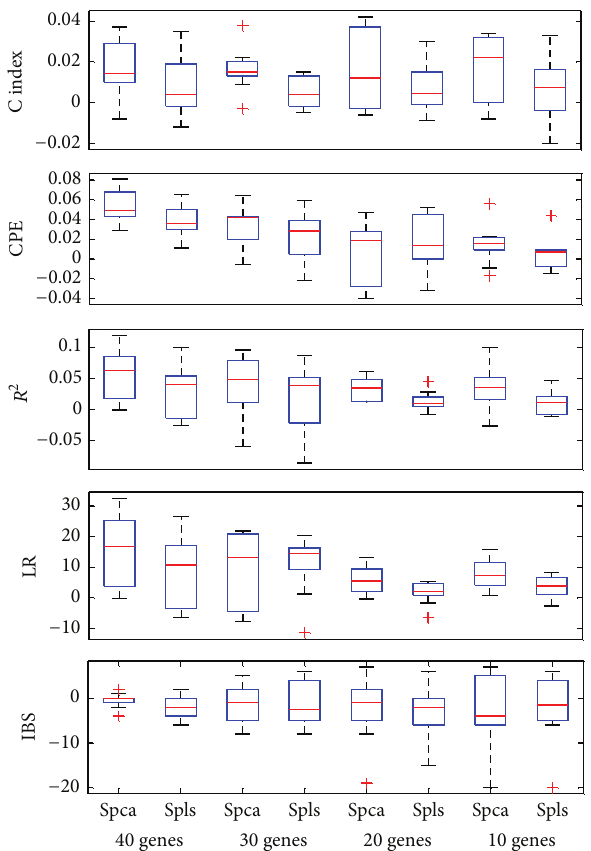
Figure 2: Box plot of the difference in model evaluation criteria between the supervised wavelet and the two other methods for simulated dataset with different number of preselected